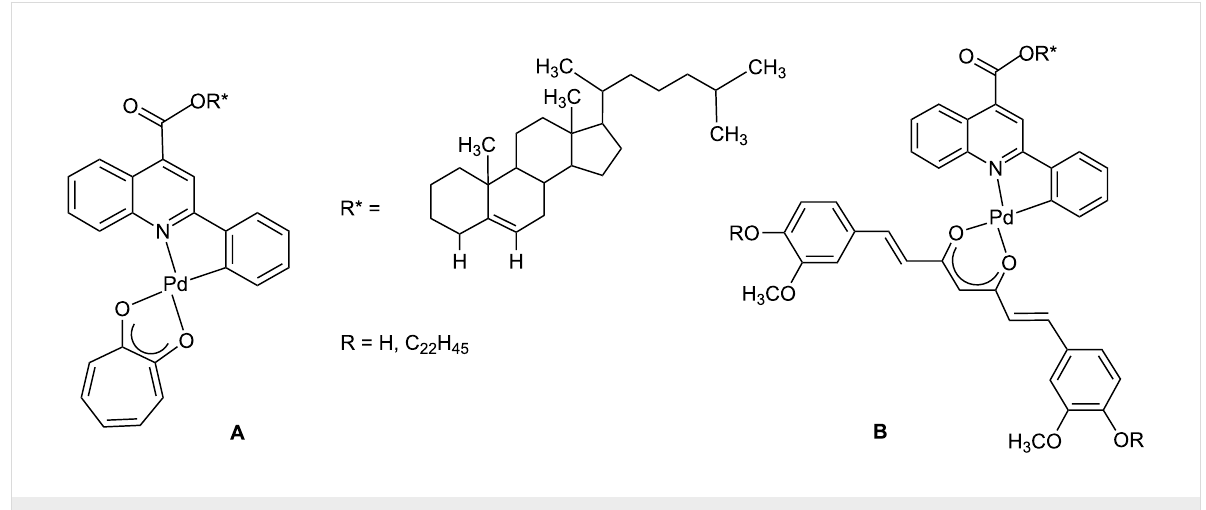
Figure 2: Molecular structure of Pd(II) complexes based on functionalised 2-phenylquinolines and β-diketonates.